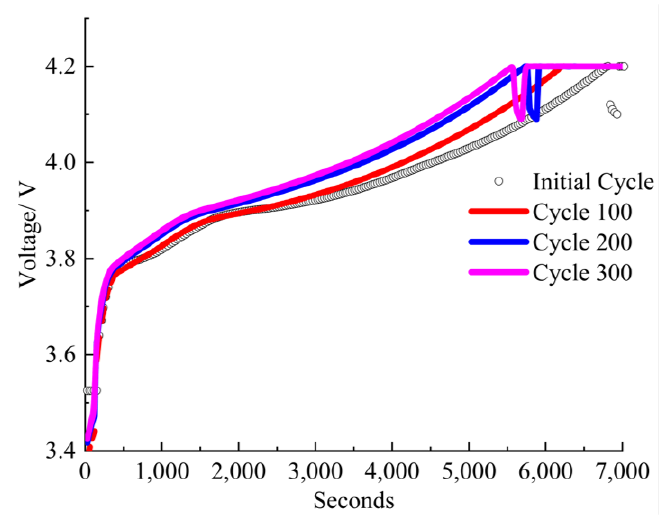
Figure 1. Voltage curves for different